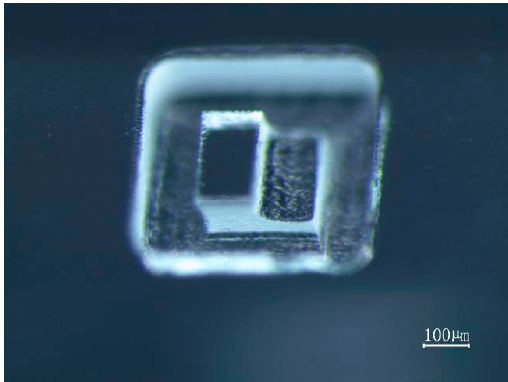
Figure 14. Three-dimensional convex structure.